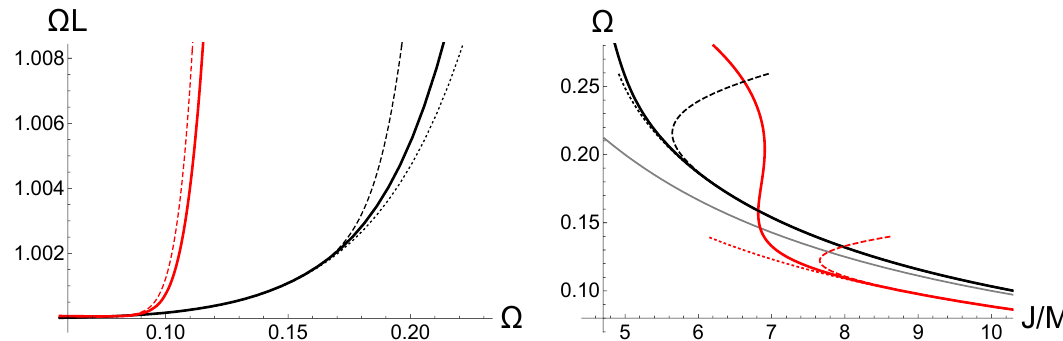
Figure 12 . The normalized peak positions of blob ring and phase diagram for N = 2 and N = 3 . The blue and red solid curves are the numerical result for N = 2 and N = 3 . The dashed and dotted curves with corresponding colors are the blob approximation with and without non-perturbative shift. The perturbative part is expanded up to O convergent for Ω . 0 . 2 . In the right panel, the black bars are also plotted by the gray curve for the